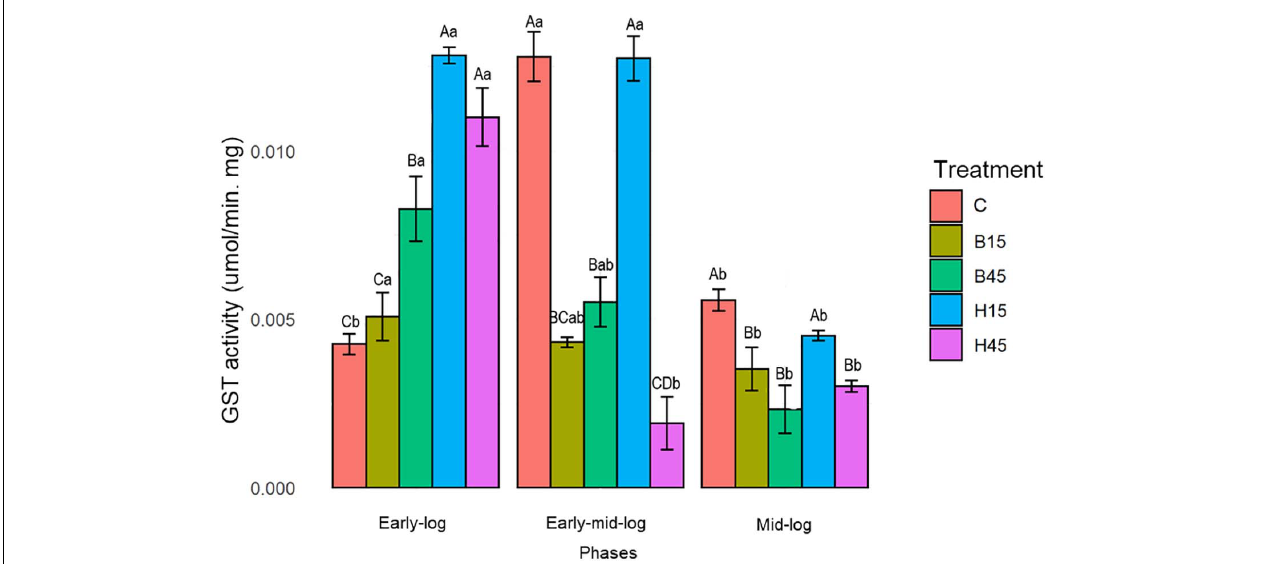
FIGURE 8 | GST activity of Pseudomonas sp. CMA 6.9 in control treatments (C) and with the herbicides Boral R (cid:13) (B15 and B45) and Heat R (cid:13) (H15 and H45) in the three growth phases indicated. Data were obtained in triplicate for each treatment and statistically analyzed using a randomized complete block design using the Duncan test ( p < 0.05). Error bars represent standard errors of the means. Different uppercase letters represent statistically significant differences between treatments at the same time; lower-case letters represent statistically significant differences between treatments at different